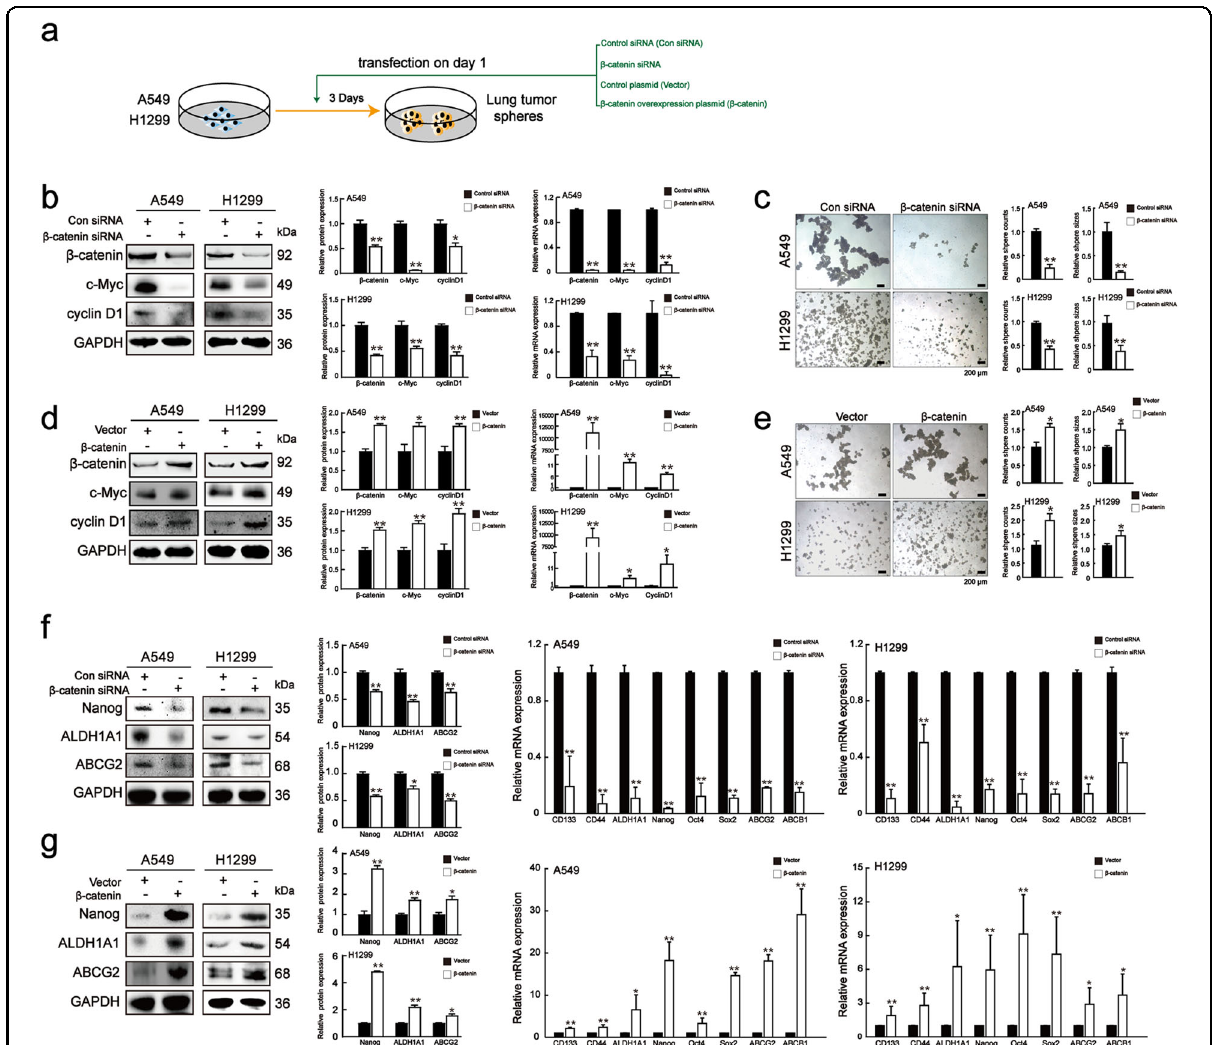
Fig. 4 β -catenin regulated lung CSC-like characteristics and drug resistance. a Schematic diagram of lung tumor spheres culture after transfection. A549 and H1299 cells were transfected with con siRNA, β -catenin siRNA, control vector, and pcDNA- β -catenin. b Protein and mRNA levels of β -catenin, c-Myc, and cyclin D1 in spheroids after being transfected with control siRNA and β -catenin siRNA. Unpaired t -test was used. Data are presented as mean ± SD ( n = 3). * p < 0.05, ** p < 0.01 compared to the con siRNA group. c Sphere-forming capacities of cells transfected with control siRNA and β -catenin siRNA. Scale bar = 100 μ m. Unpaired t -test was used. Data are presented as mean ± SD ( n = 3). ** p < 0.01 compared to the con siRNA group. d Protein and mRNA levels of β -catenin, c-Myc and cyclin D1 in spheroids after transfected with control vector and pcDNA- β -catenin. Unpaired t-test was used. Data are presented as mean ± SD ( n = 3). * p < 0.05, ** p < 0.01 compared to the vector group. e Sphere-forming capacities of cells transfected with control vector and pcDNA- β -catenin. Scale bar = 100 μ m. Unpaired t -test was used. Data are presented as mean ± SD ( n = 3). * p < 0.05 compared to the vector group. f Protein and mRNA levels of lung CSC markers and drug resistance genes in spheroids after being transfected with control siRNA and β -catenin siRNA. Unpaired t -test was used. Data are presented as mean ± SD ( n = 3). * p < 0.05, ** p < 0.01 compared to the con siRNA group. g Protein and mRNA levels of lung CSC markers and drug resistance genes in spheroids after being transfected with control vector and pcDNA- β -catenin. Unpaired t -test was used. Data are presented as mean ± SD ( n = 3). * p < 0.05, ** p < 0.01 compared to the vector